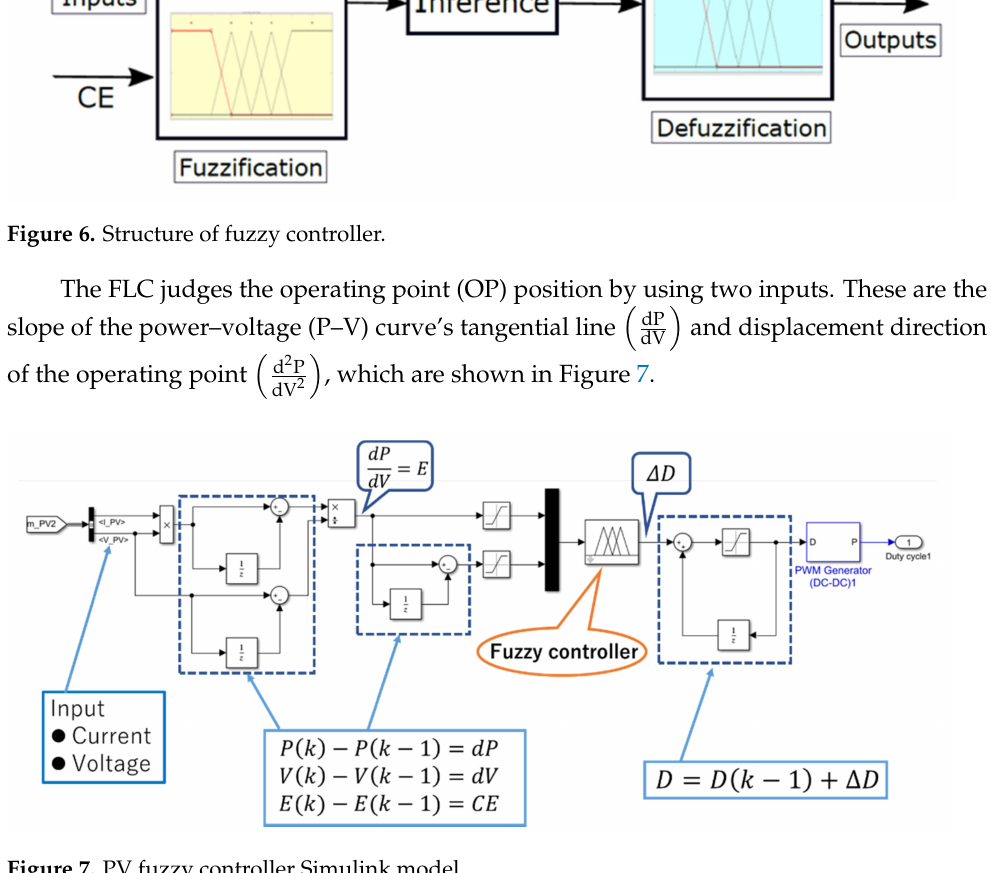
Figure 7. PV fuzzy controller Simulink